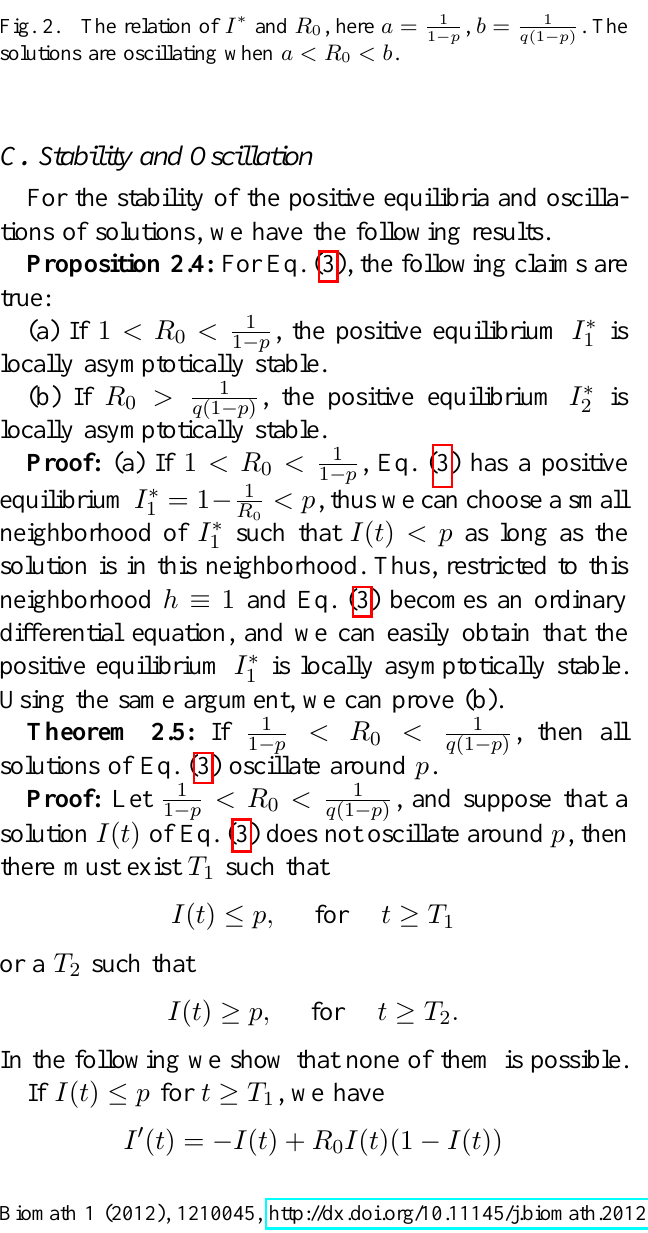
, b = 1 . The 1 − p q (1 − p )